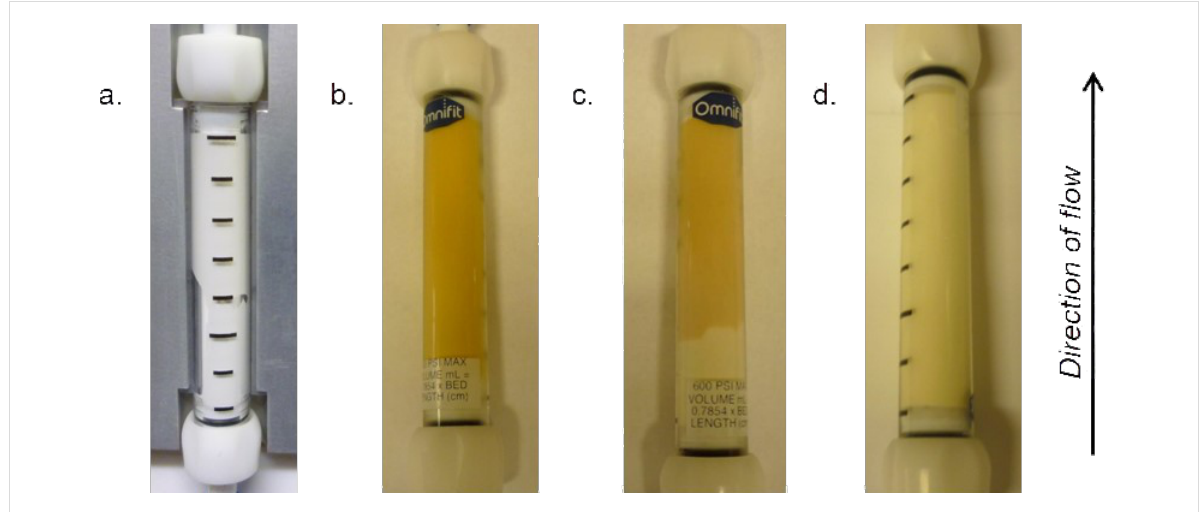
Figure 1: a. An unfunctionalised triphenylphosphine monolith; b. Monolith after functionalisation with carbon tetrabromide at 0 °C; c. Monolith after complete consumption of the active Ramirez gem -dibromoolefination species; d. Monolith after complete consumption of the active Ramirez gem -di- bromoolefination species and the Appel brominating